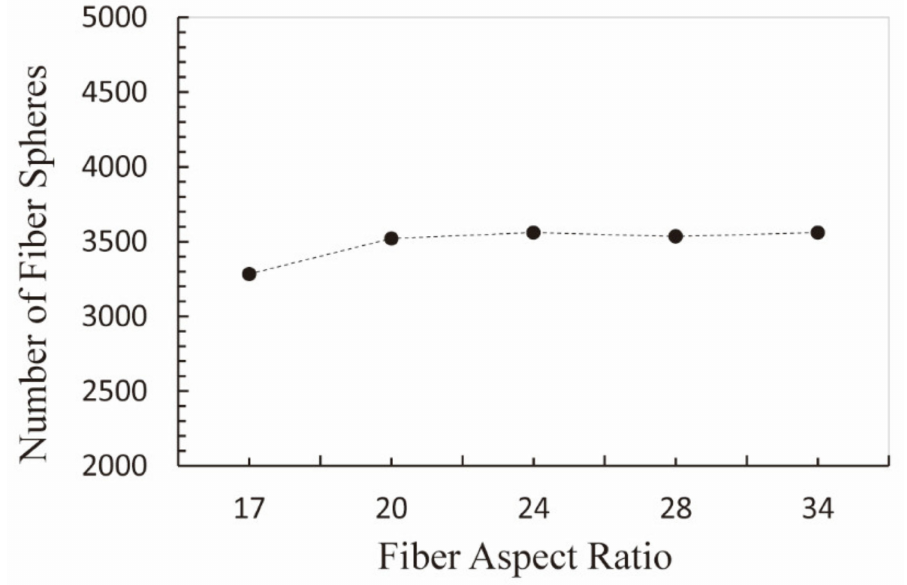
Figure 14. The variation of total fiber spheres number with fiber’s aspect ratio at the optimum fiber